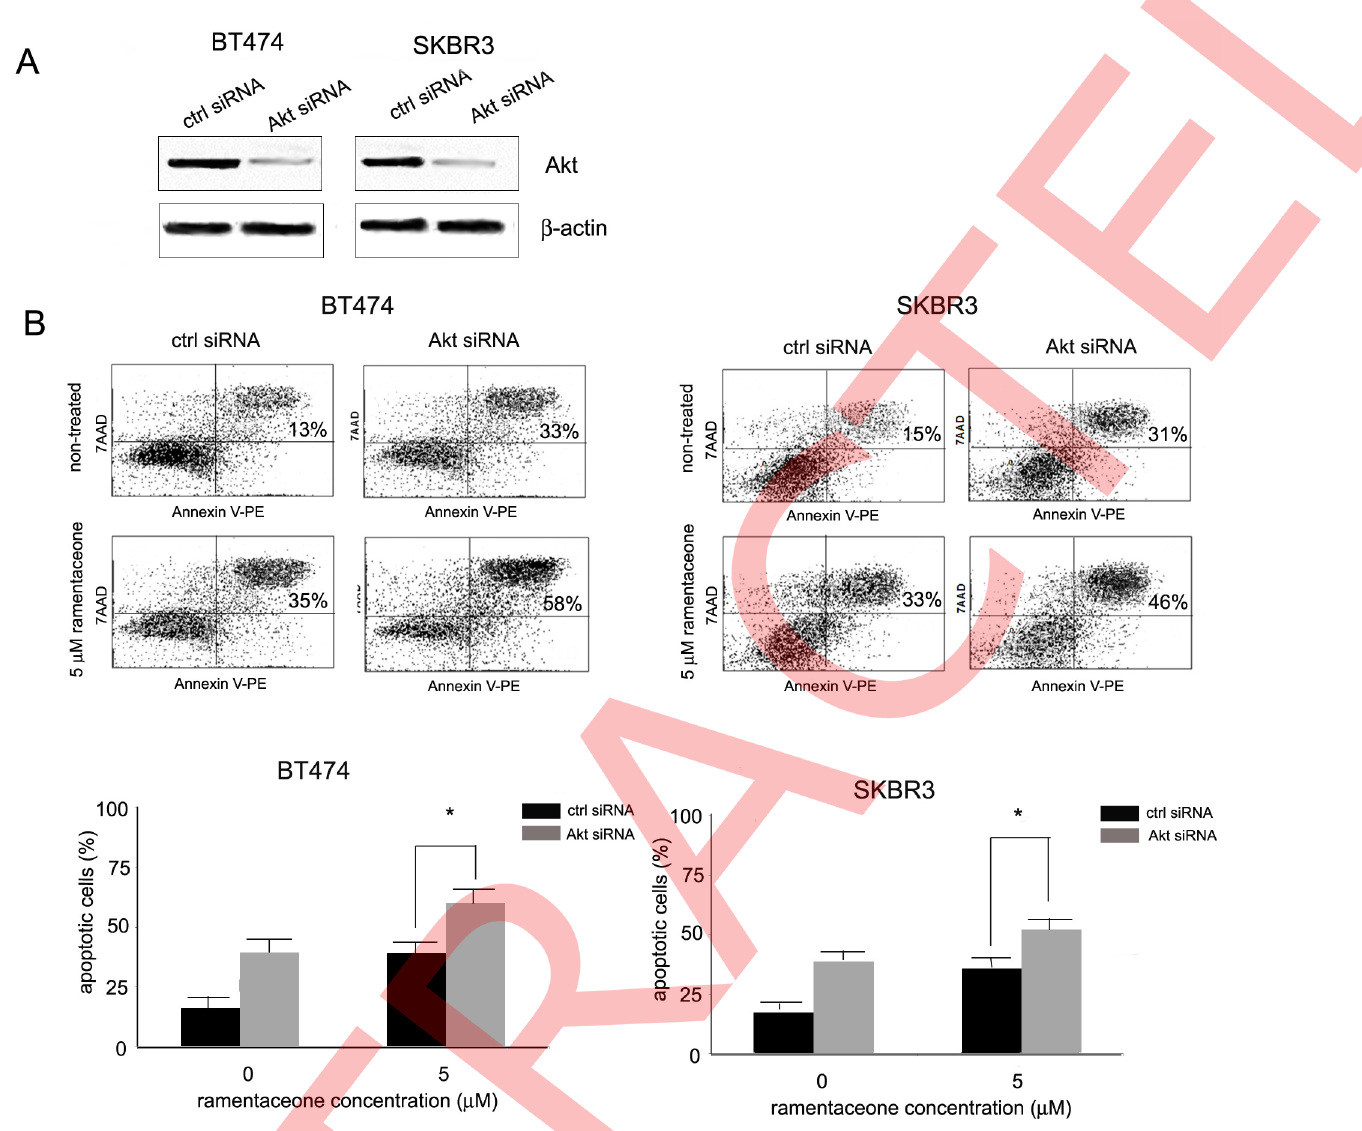
Fig 8. The role of Akt inhibition in ramentaceone-mediated apoptosis induction. (A) Silencing of Akt by siRNA in BT474 and SKBR3 cells. Cells were transiently transfected with Akt siRNA and 24 after transfection, Akt silencing was confirmed with Western blot analysis. (B) Induction of apoptosis by ramentaceone in cells transfected with Akt siRNA and control siRNA. 24 h after transfection cells were treated with ramentaceone (5 μ M) for 24 h, stained with Annexin V-PE/7-AAD, and analyzed by flow cytometry. Representative of three independent experiments. p < 0.05 ( * ) indicate differences between control siRNA and Akt siRNA transfected cells treated with